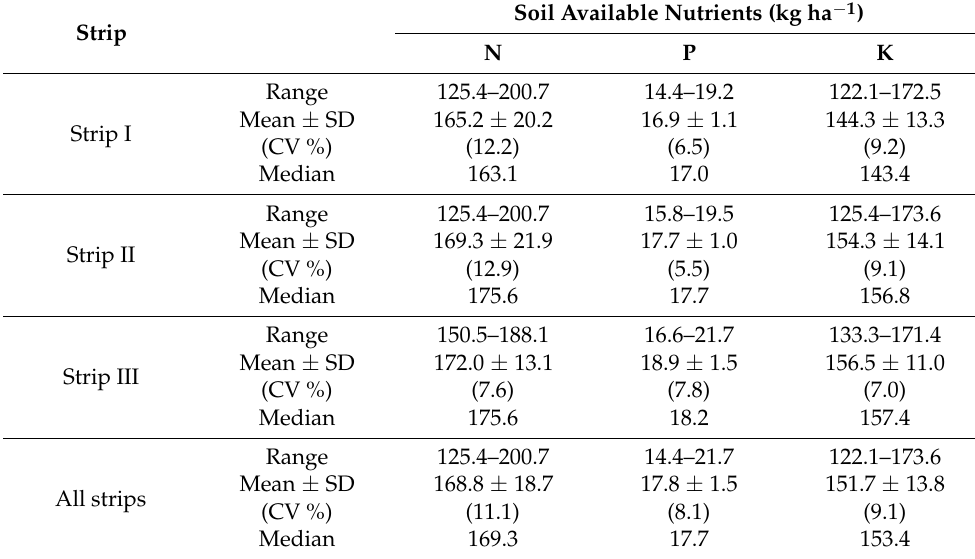
Table 2. Descriptive statistics of available soil nutrients (0–15), nutrients after the soil